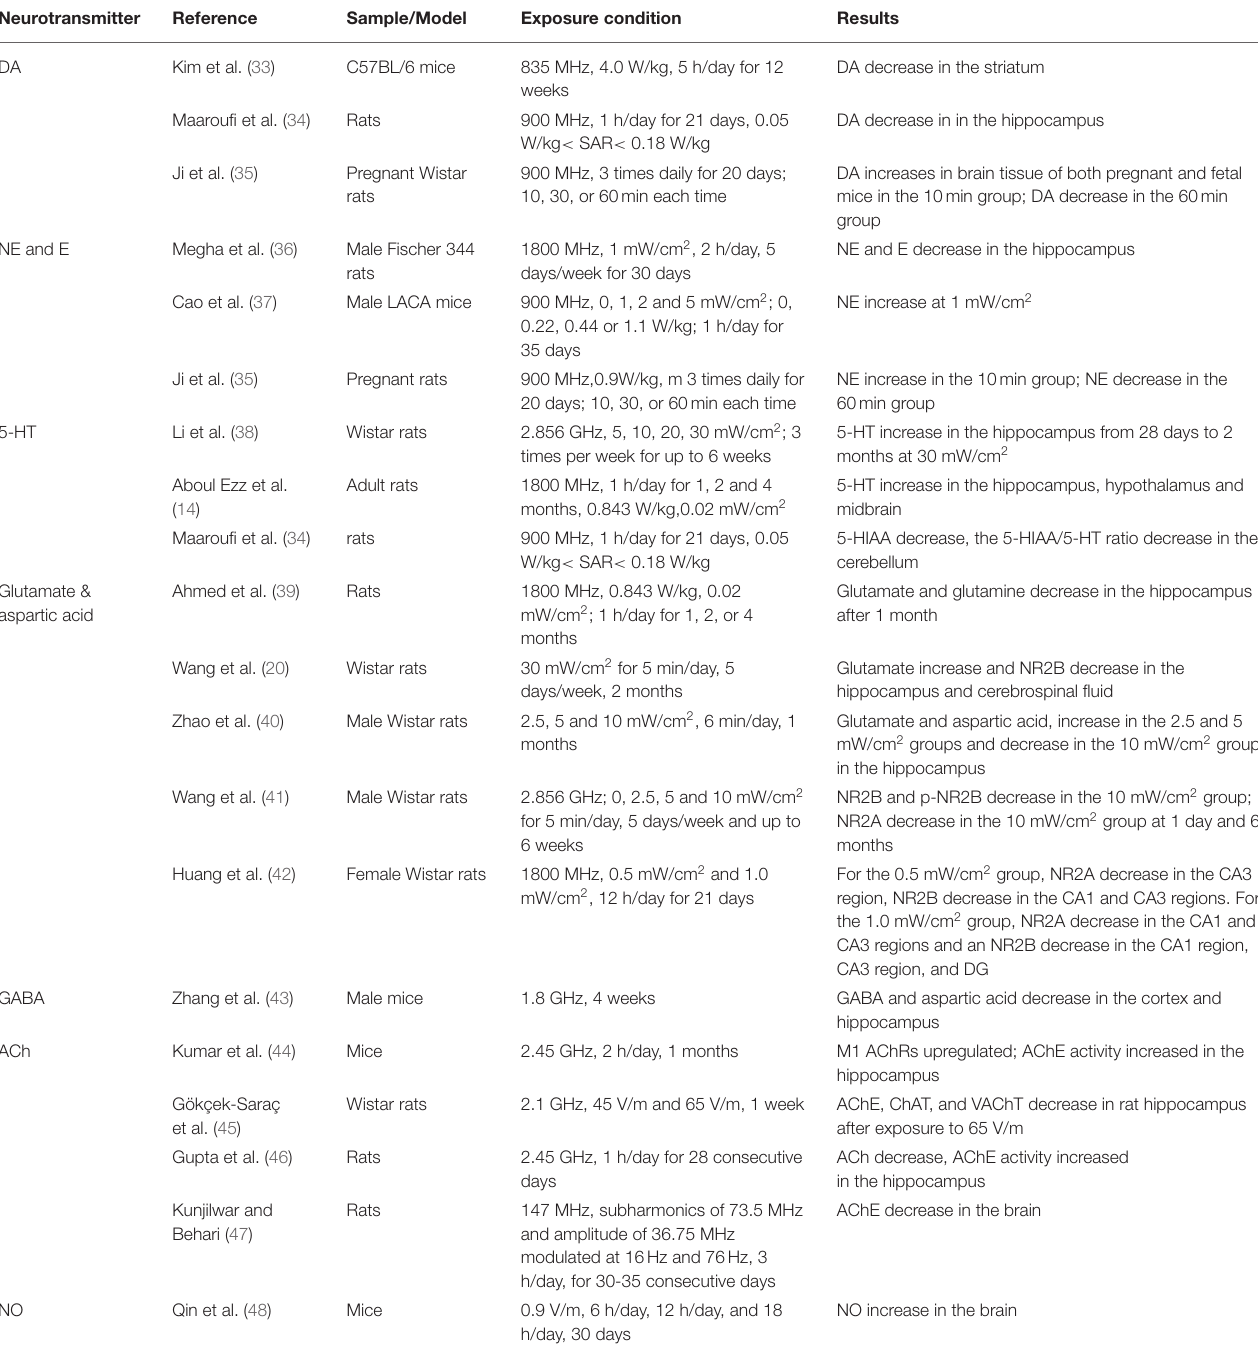
TABLE 2 | The influence of long-term EMR exposure on neurotransmitters in the brain.